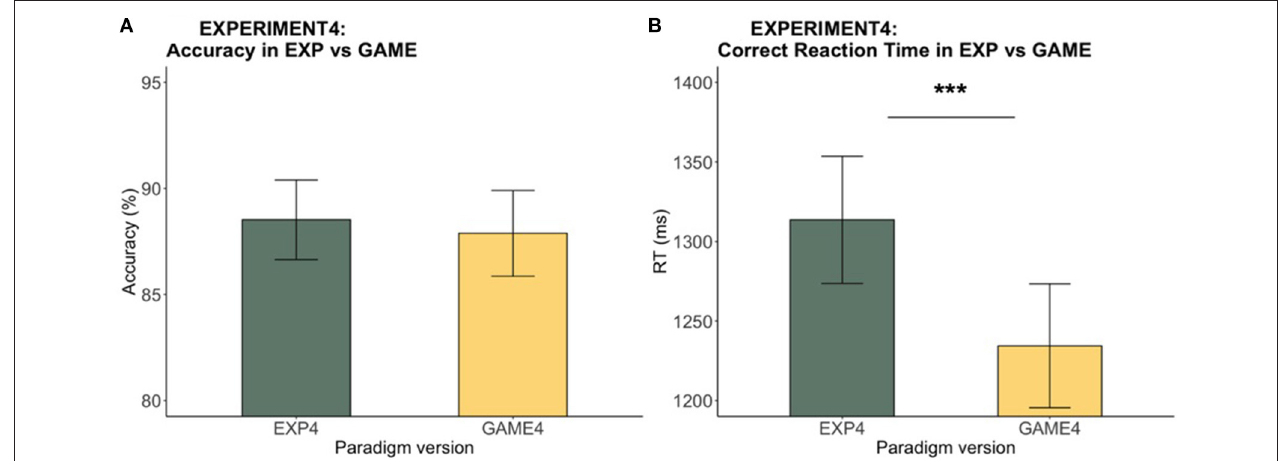
FIGURE 11 | Experiment 4: Experiment vs. game accuracy and RT. The bar chart indicates (A) the mean accuracy and (B) the mean RTs across participants while the error bars shows the 95% confidence intervals. While there was no significant difference in terms of accuracy, game RT was significantly faster than RT in the experiment (*** p <